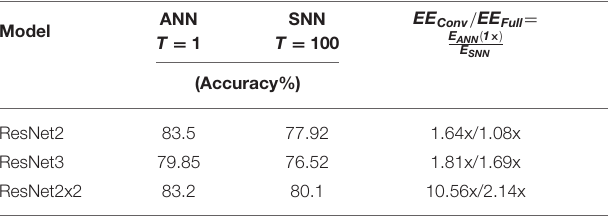
TABLE 12 | Accuracy and EE benefits for STDP trained SNN with ConvNN classifier ( Table 13 ) appended to ResNet2, ResNet2x2, ResNet3 topology (refer to Table 7 ) on CIFAR10 data.